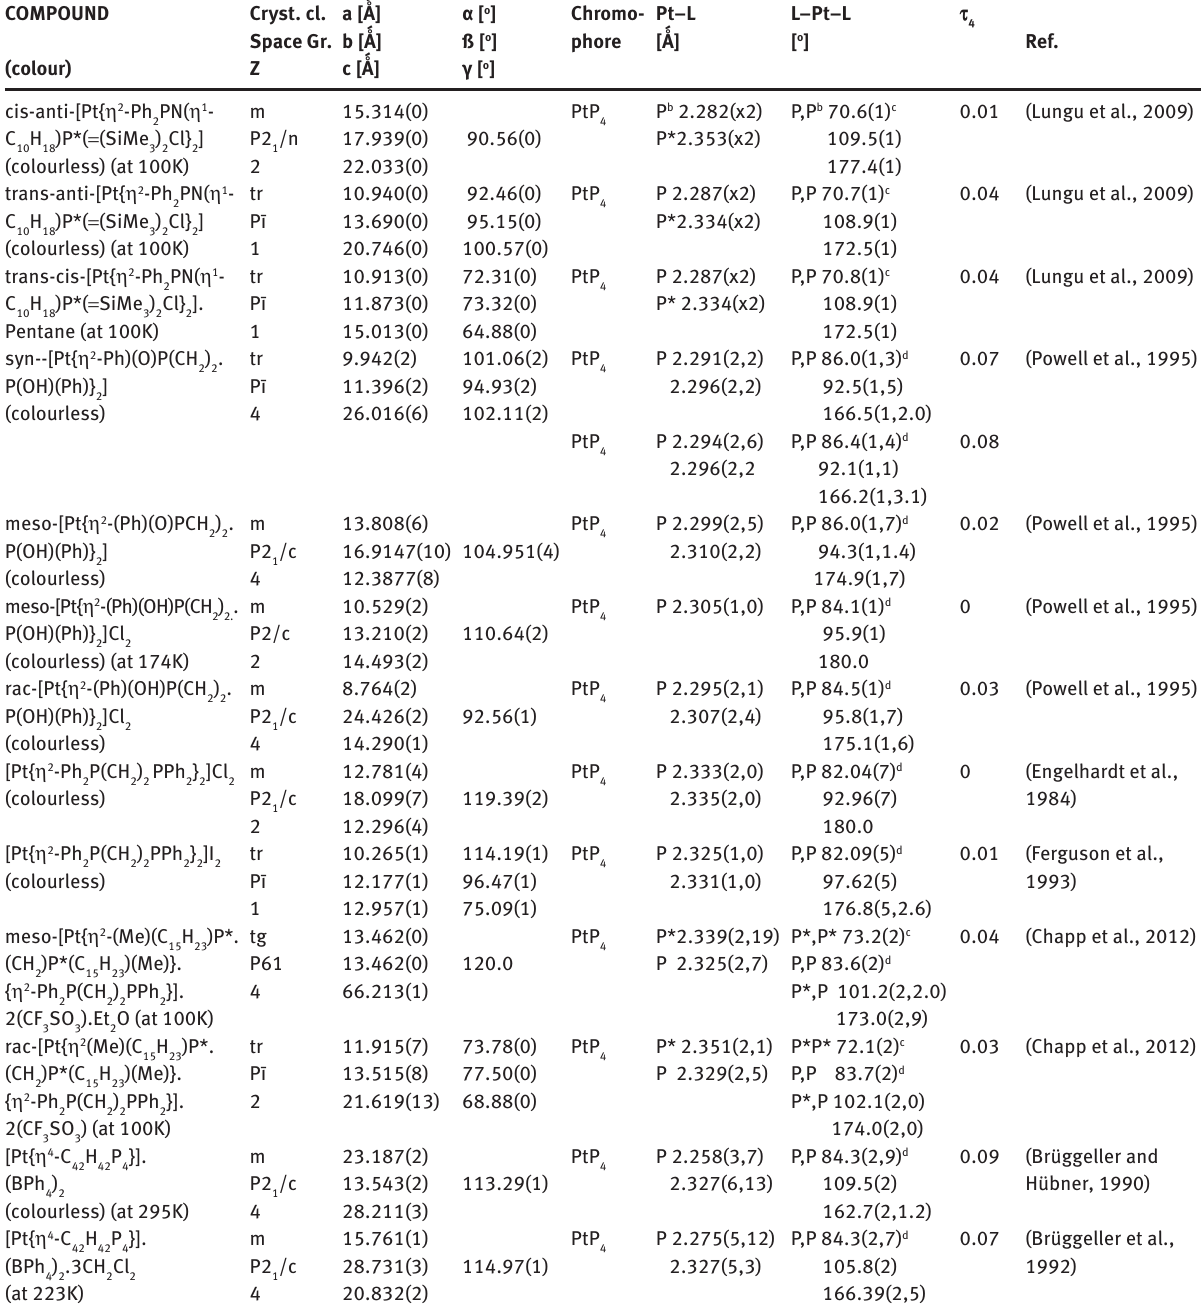
derivatives – distortion isomers a . 4